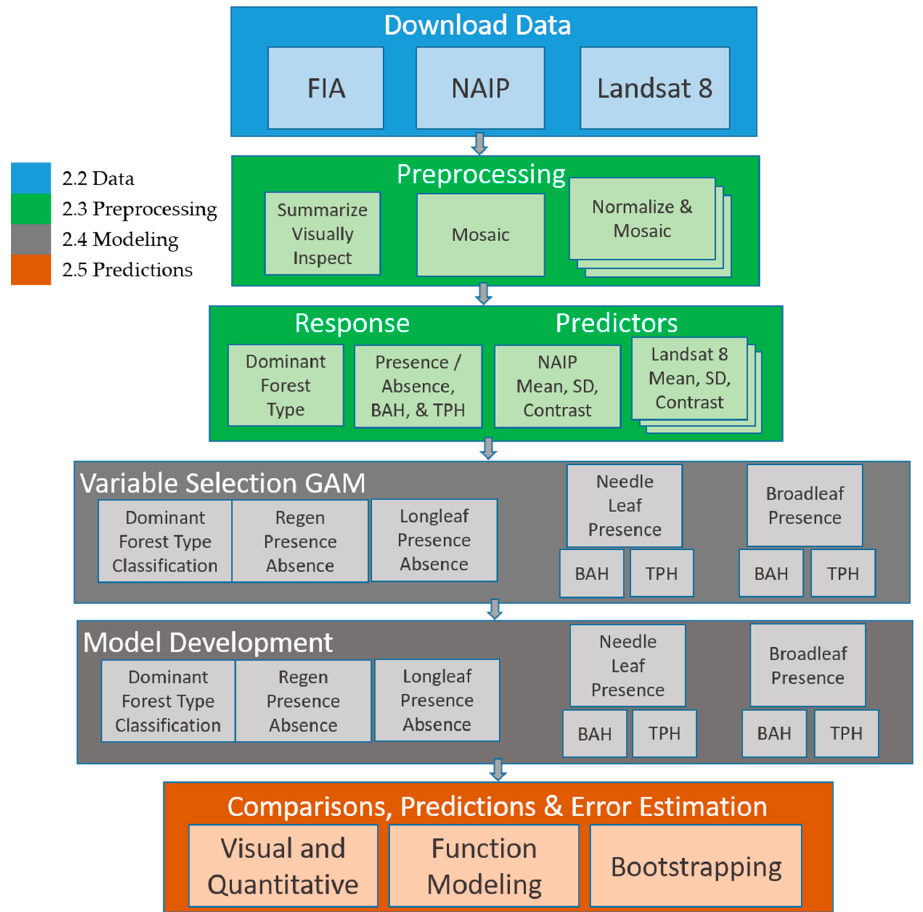
Figure 3. Visual depiction of study methods. Step groupings identified by color in the figure correspond to named subsections.